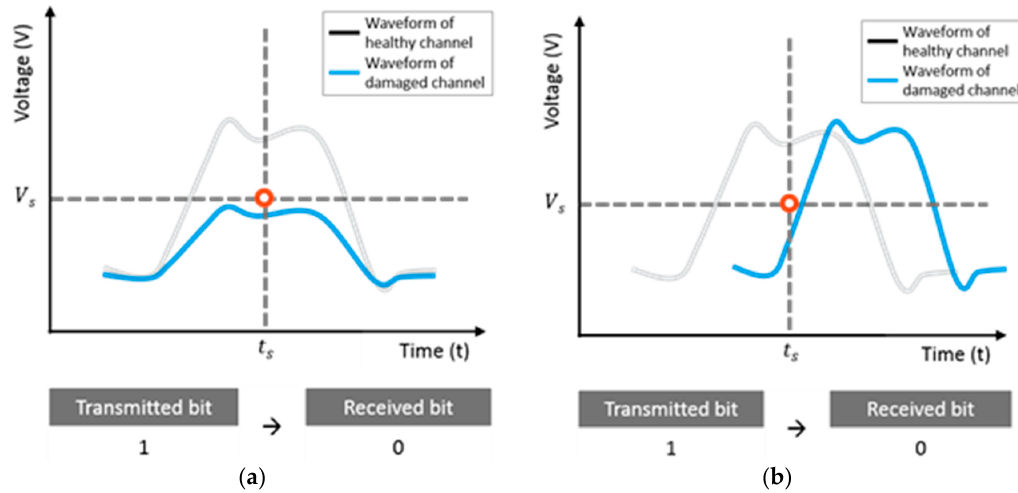
Figure 3. Bit error generation ( a ) by signal loss and ( b ) by timing noise.